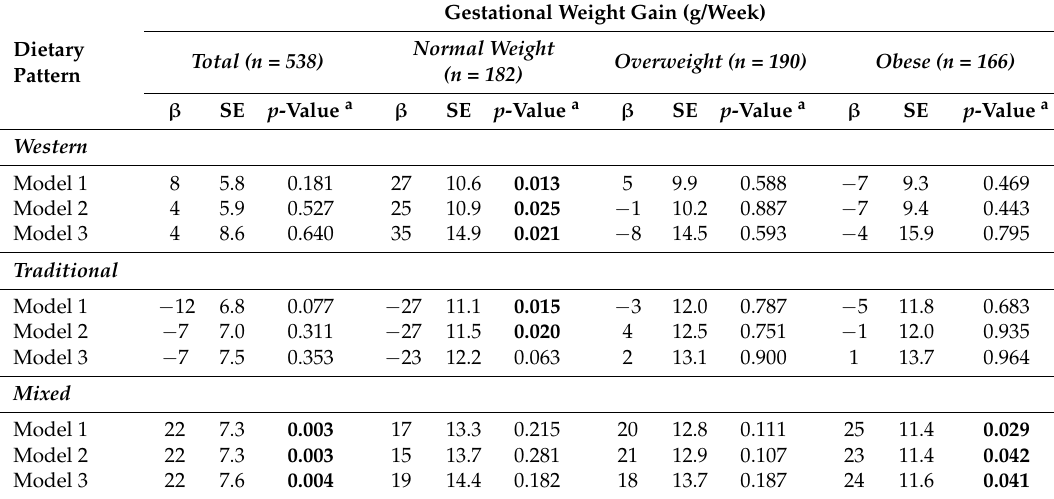
Table 3. Associations between dietary pattern scores and rate of gestational weight gain in South African